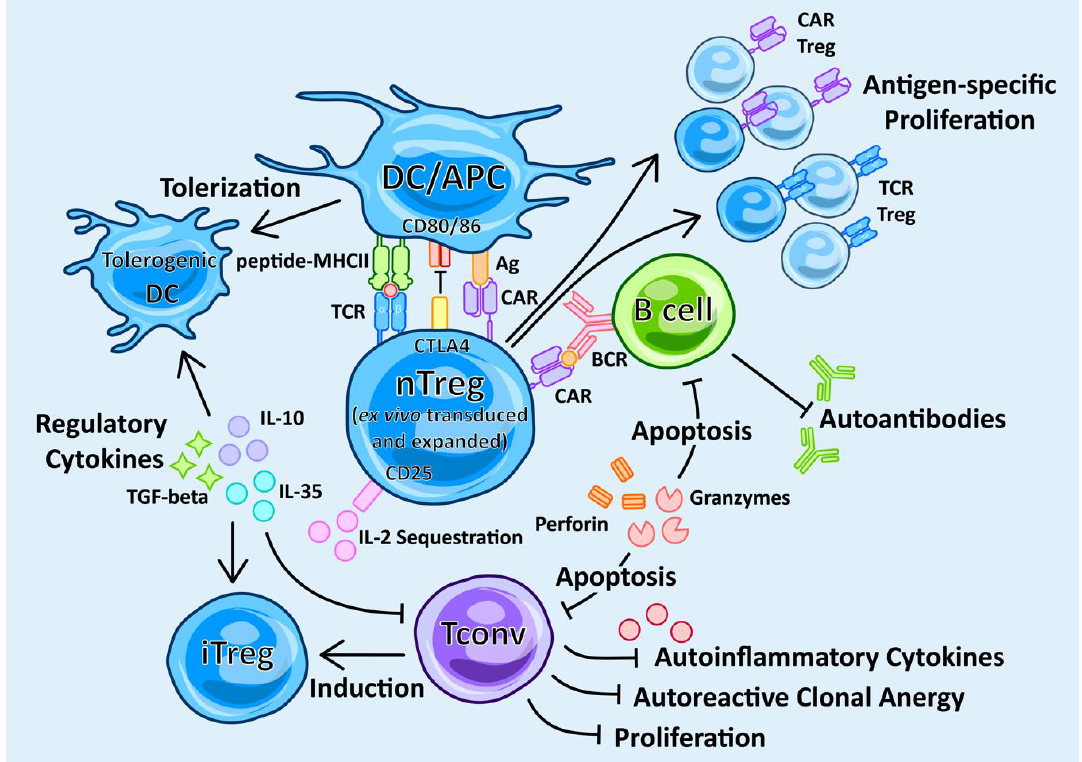
Figure 2. Mechanisms of action in Treg therapy. Tregs as a cell-based therapy work in many ways to restore immune tolerance. They secrete anti-inflammatory regulatory cytokines, such as IL-10, IL-35 and TGF-beta, which promote the induction of Tconvs into iTregs and the tolerization of dendritic cells (DC) to tolerogenic DCs. Tregs act as a sink for IL-2 through the cell surface IL-2 receptor, CD25. Tregs can directly kill inflammatory cells, such as Tconvs and B cells, by the secretion of perforin and granzymes. Tregs can suppress autoreactive B cells and autoantibody production, as well as suppressing autoreactive Tconvs. Treg therapy can be non-specific by the use of ex vivo-expanded polyclonal Tregs expressing a natural repertoire of T cell receptors (TCRs). By transducing either an antigen-specific TCR or chimeric antigen receptor (CAR) onto the Treg, the Treg can be redirected to specifically activate and target the auto-antigenic immune response. Such antigen-specific interactions increase the potency of the Treg response mechanisms in response to the autoantigen of interest, as well as promoting a clonally expanded set of transduced Tregs to further curtail